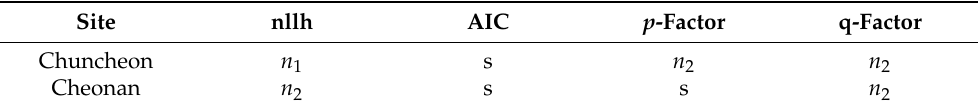
Table 4. Results of determining optimal model.